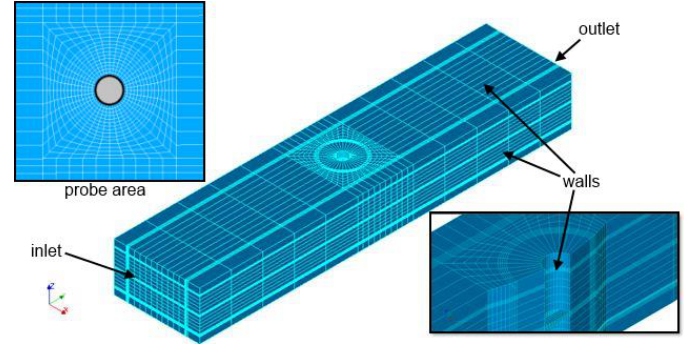
Figure 2. Setup of the sensor probe arrangement and display of the main features of the